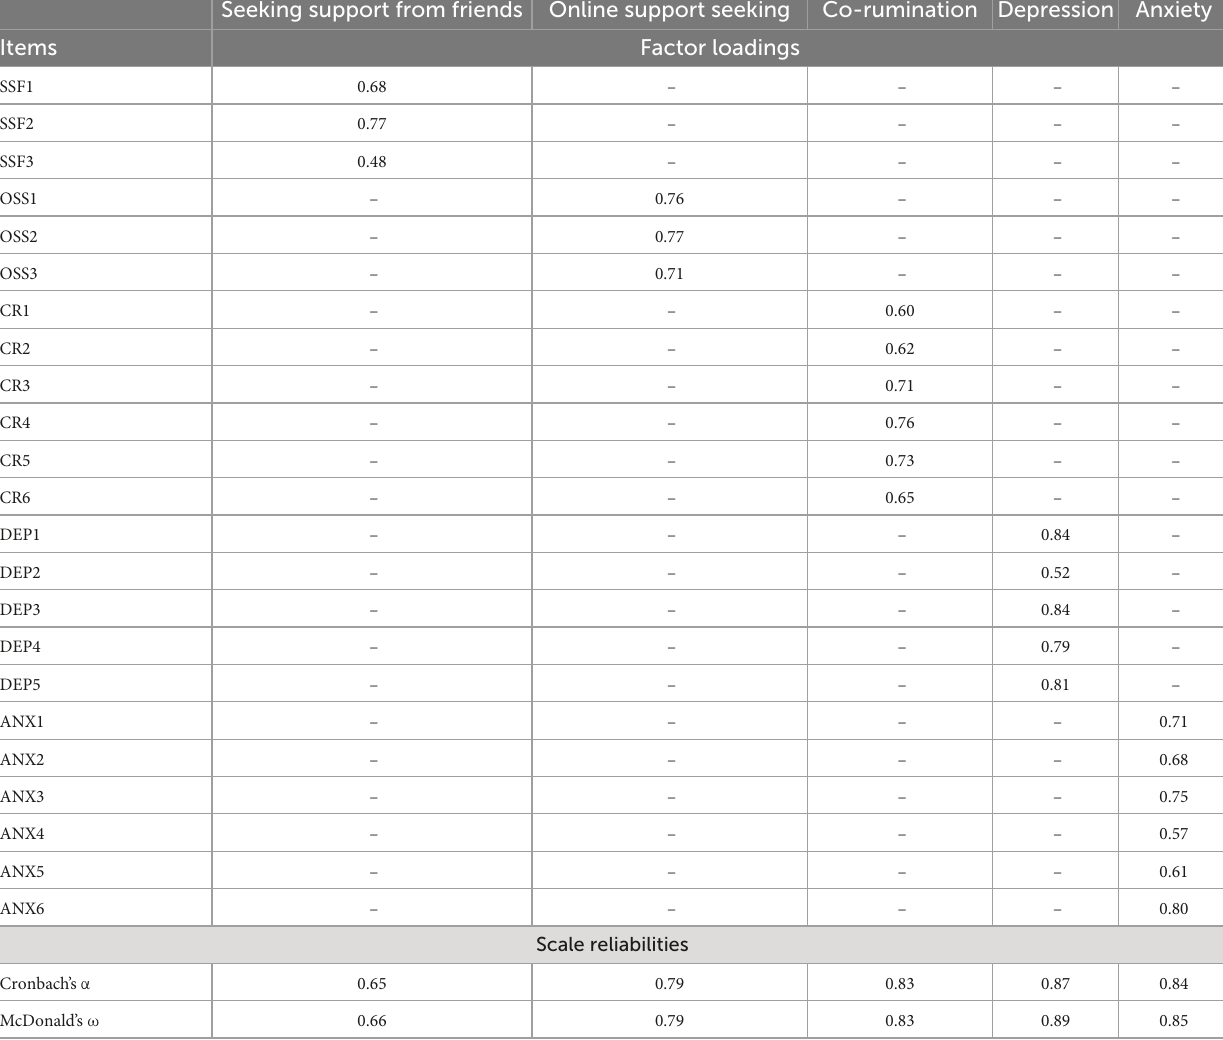
TABLE 1 Factor loadings for each latent factors and scale reliabilities.